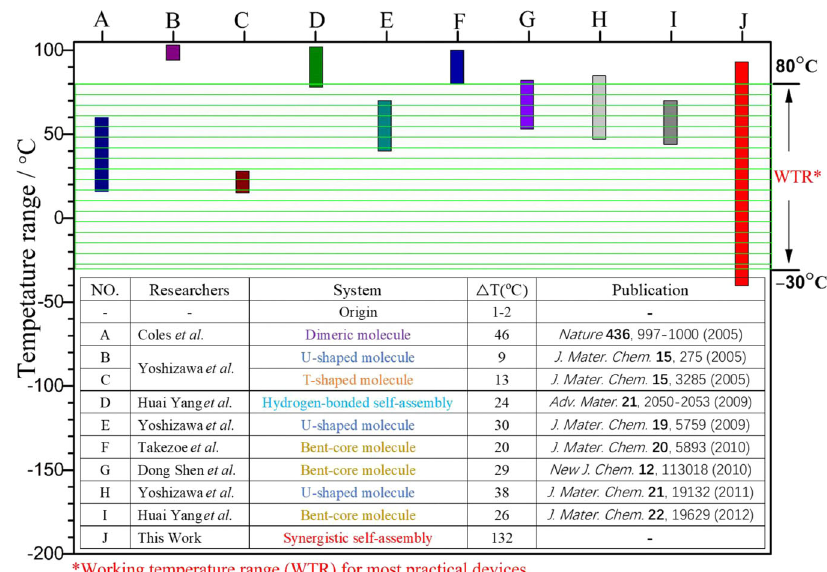
Fig. 4 Development course of the temperature range of low molecular weight BPLCs. The column diagram indicates the temperature range of low molecular weight BPLCs obtained by different means, and the inset table shows the development course summary of low molecular weight